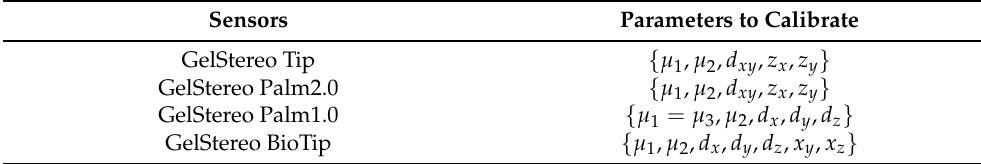
Table 2. The parameter sets to be calibrated in each